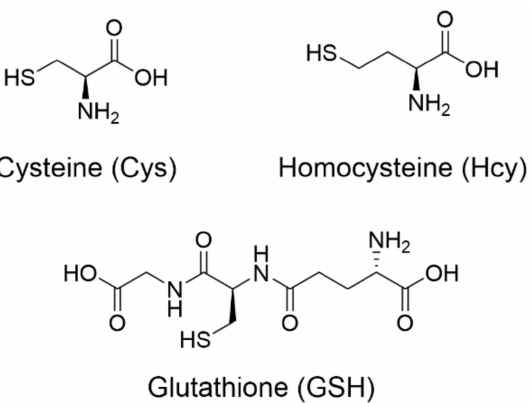
Figure 1. Important biothiols, including cysteine (Cys), homocysteine (Hcy), and glutathione (GSH) present in